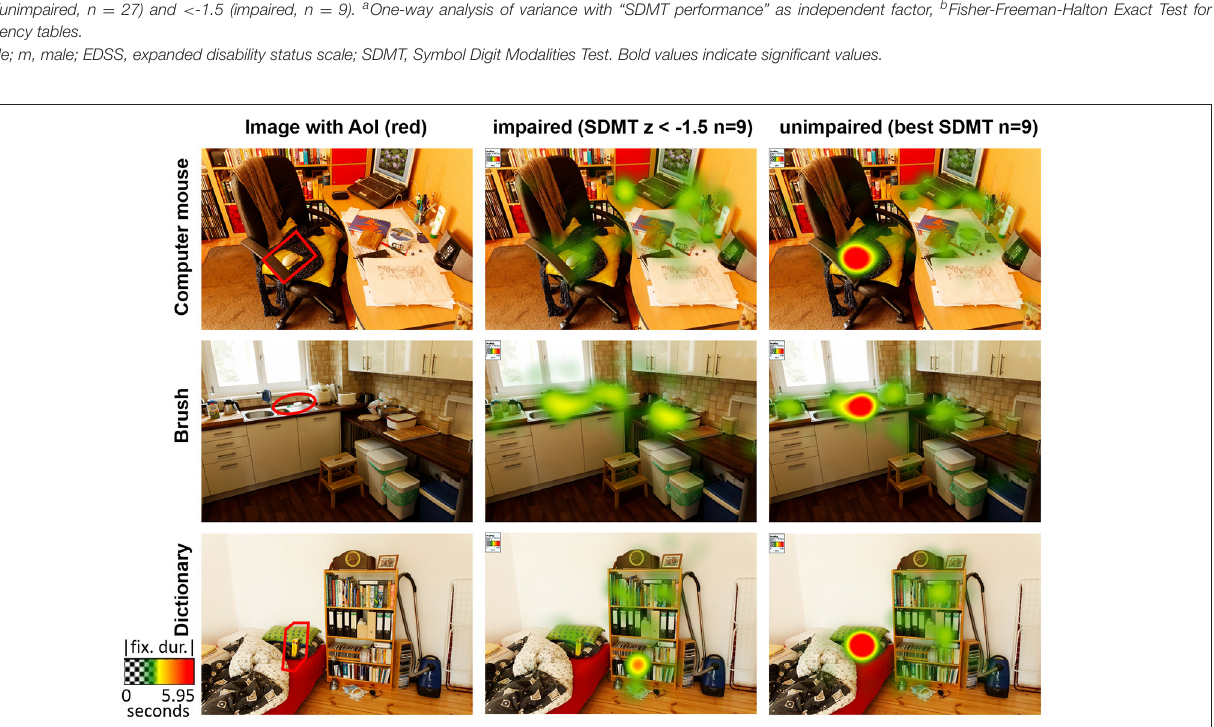
processing unit was connected to the recording notebook (Dell Inspirion 7559-0092, Intel R (cid:13) Core TM i7-6700HQ) running Tobii Pro Studio (Version 3.4.8.1348, Tobii, Danderyd, Sweden). The eye tracker was placed on the lower end of the display of the recording notebook. The screen had a resolution of 1.920 × 1.080 pixels and a diagonal of 39.6 cm. We used standardized room